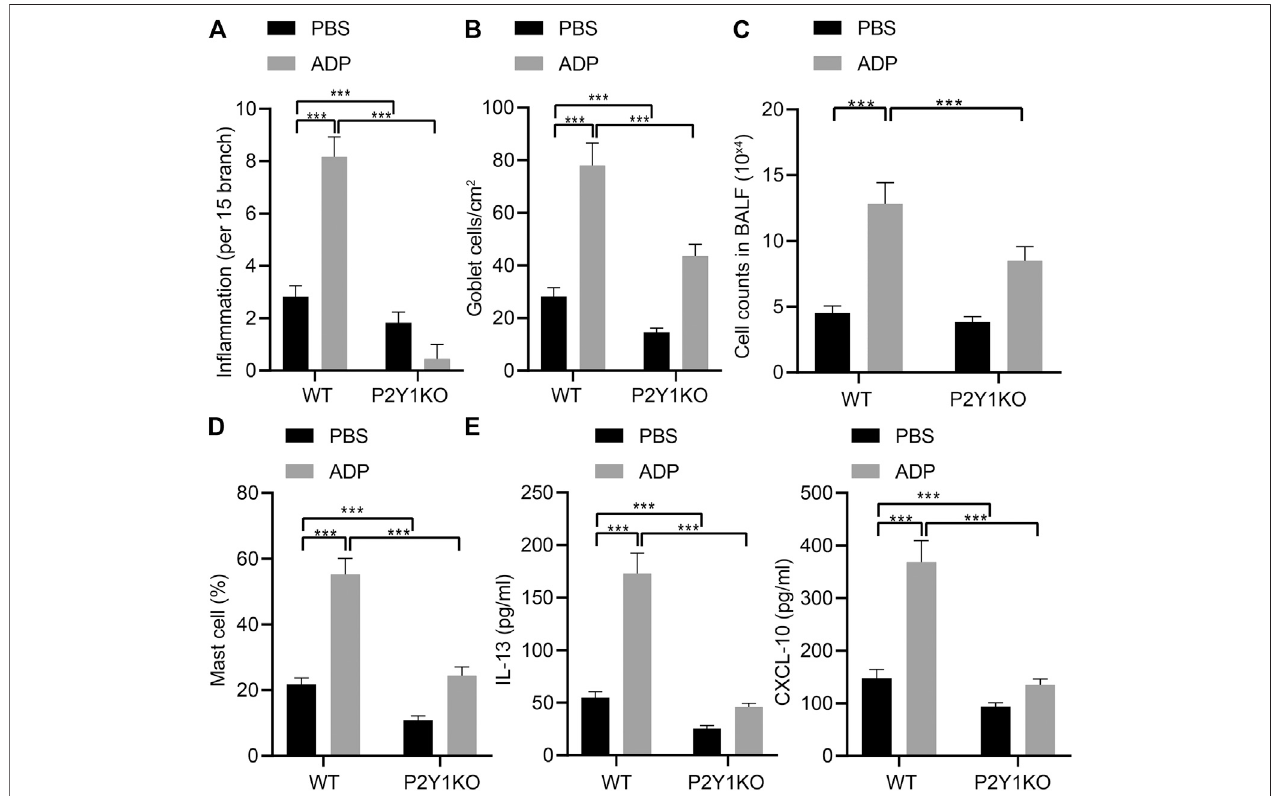
FIGURE 4 | P2Y1 may be involved in ADP-mediated airway in fl ammation in asthmatic mice. (A) Quantitative analysis of pathological scores of lung in fl ammation. (B) Quantitative analysis of the number of PAS-positive goblet cells in the lungs. (C) The number of cells in fi ltrated in the lungs of mice. (D) The proportion of MCs in fi ltratingthelungsofmice. (E) ThelevelsofcytokinesIL-13andCXCL10inBALFofmice.* p < 0.05,** p < 0.01,and*** p < 0.001.Measurementdatawereexpressedby the mean ± standard deviation, analyzed by independent sample t test, and the experiment was repeated 3